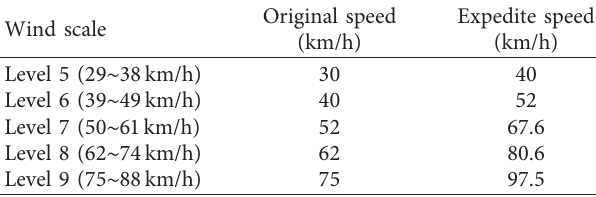
Table 7: Wind scale setting.